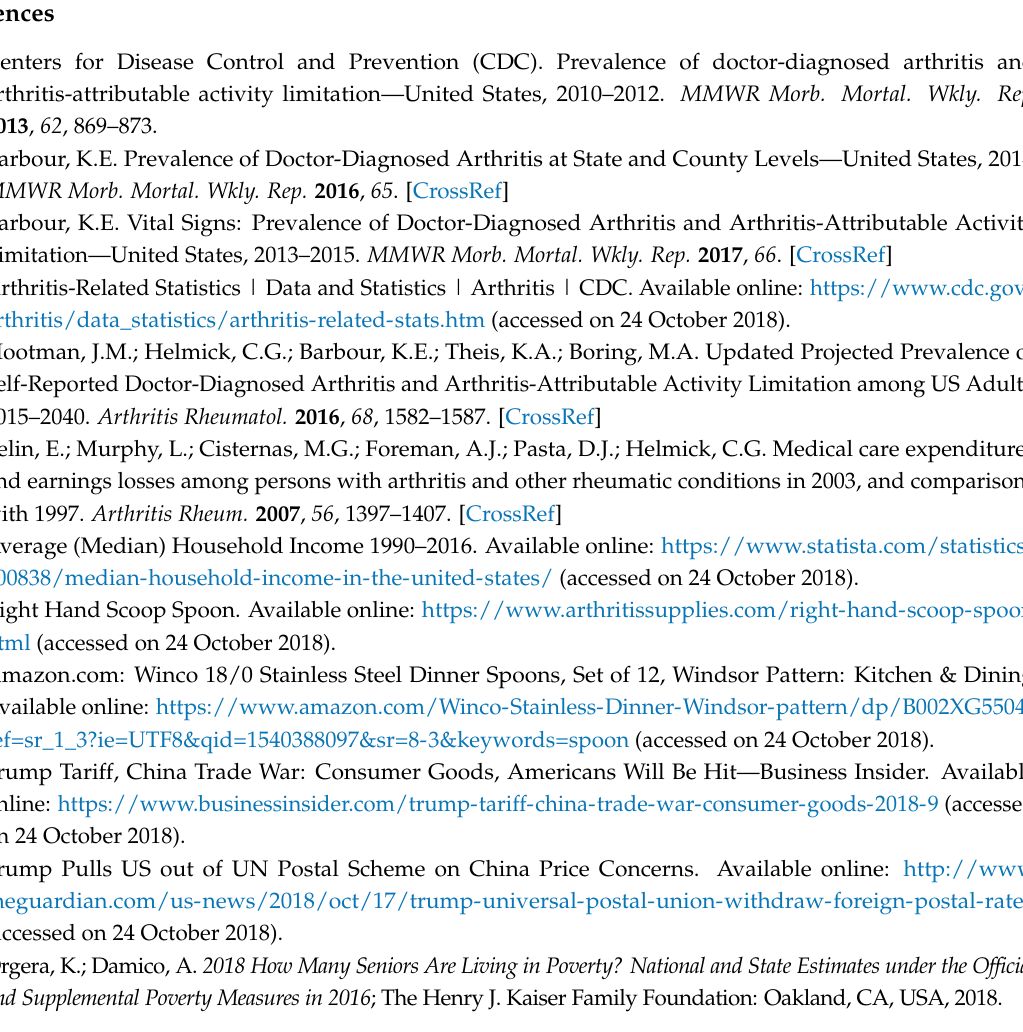
Table S1: Spreadsheet of equivalent commercial adaptive